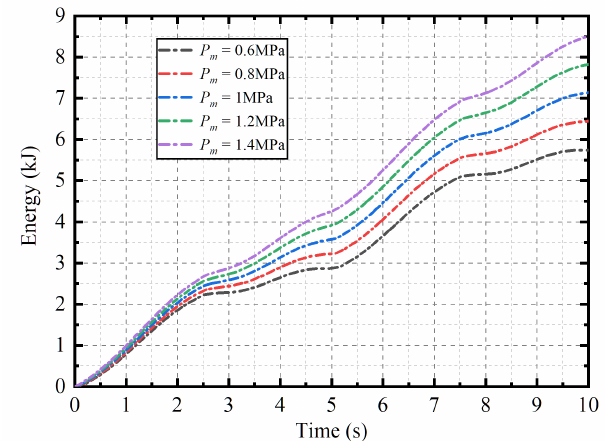
Figure 26. Energy consumption at safety margin pressure P m